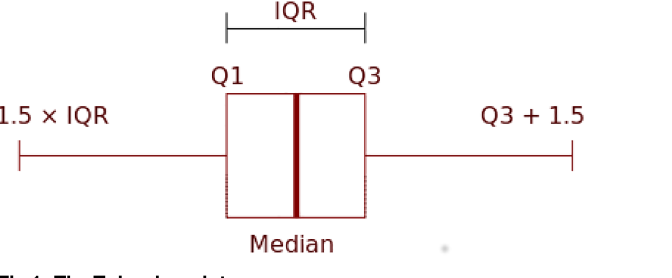
Fig 1. The Tukey boxplot.